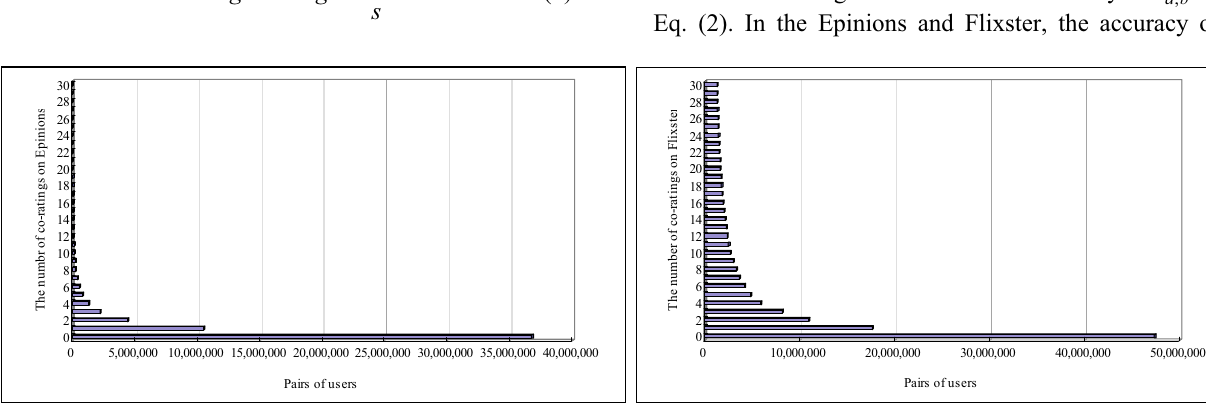
Fig. 2. This is the distribution of items